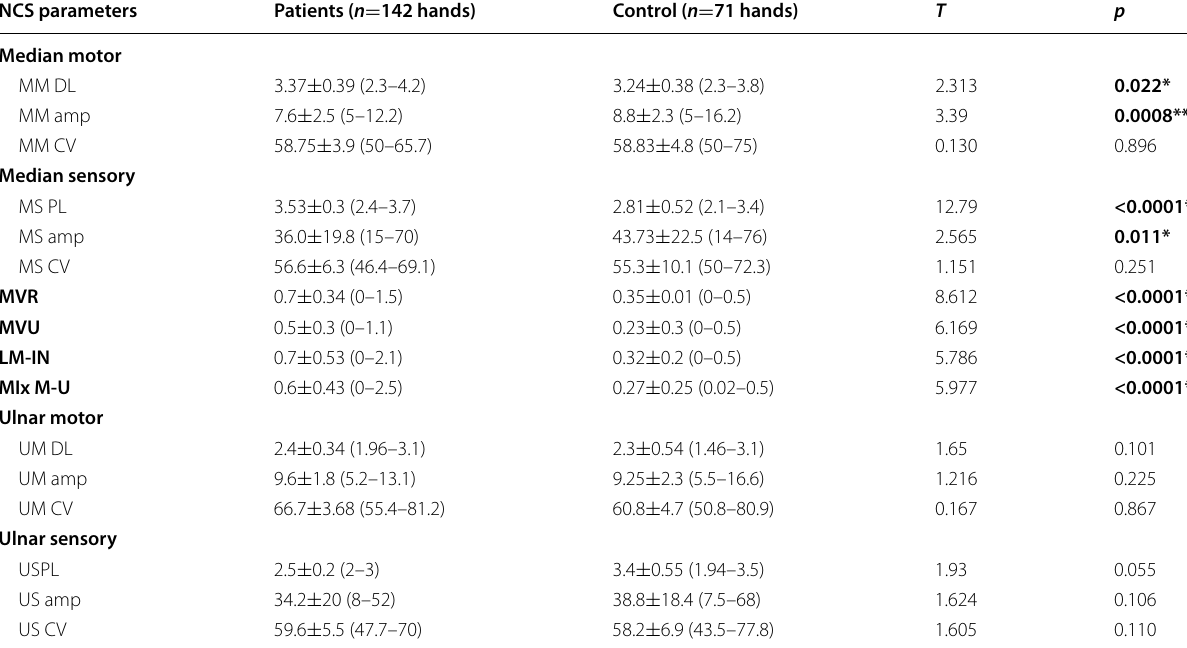
DL , distal latency; amp , amplitude; CV , conduction velocity; MM , median motor; MS , median sensory; PL , peak latency; MVR , median versus radial study; MVU , median versus ulnar sensory study; LM-IN , median versus ulnar lumbrical‑ interossei motor study; Mix M-U , median versus ulnar palmar mixed nerve study; UM , ulnar